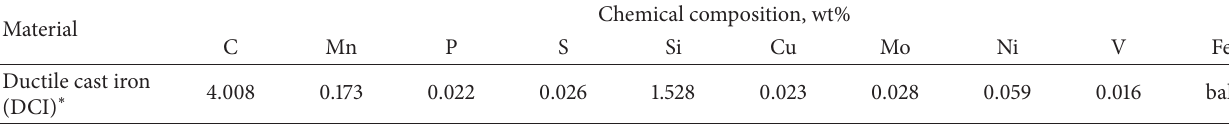
Table 1: Chemical composition of the experimental